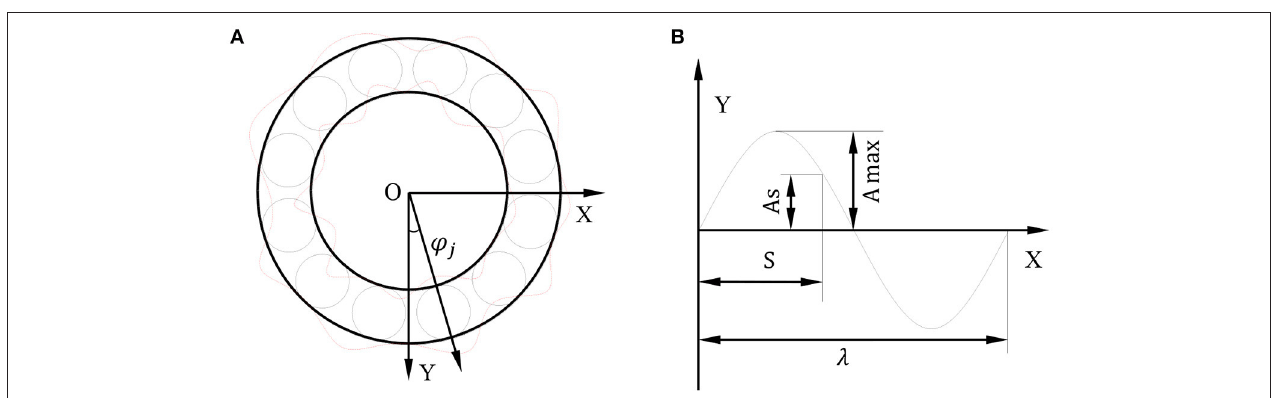
FIGURE 4 | Waviness model. (A) Raceways waviness model. (B) Sine curve.